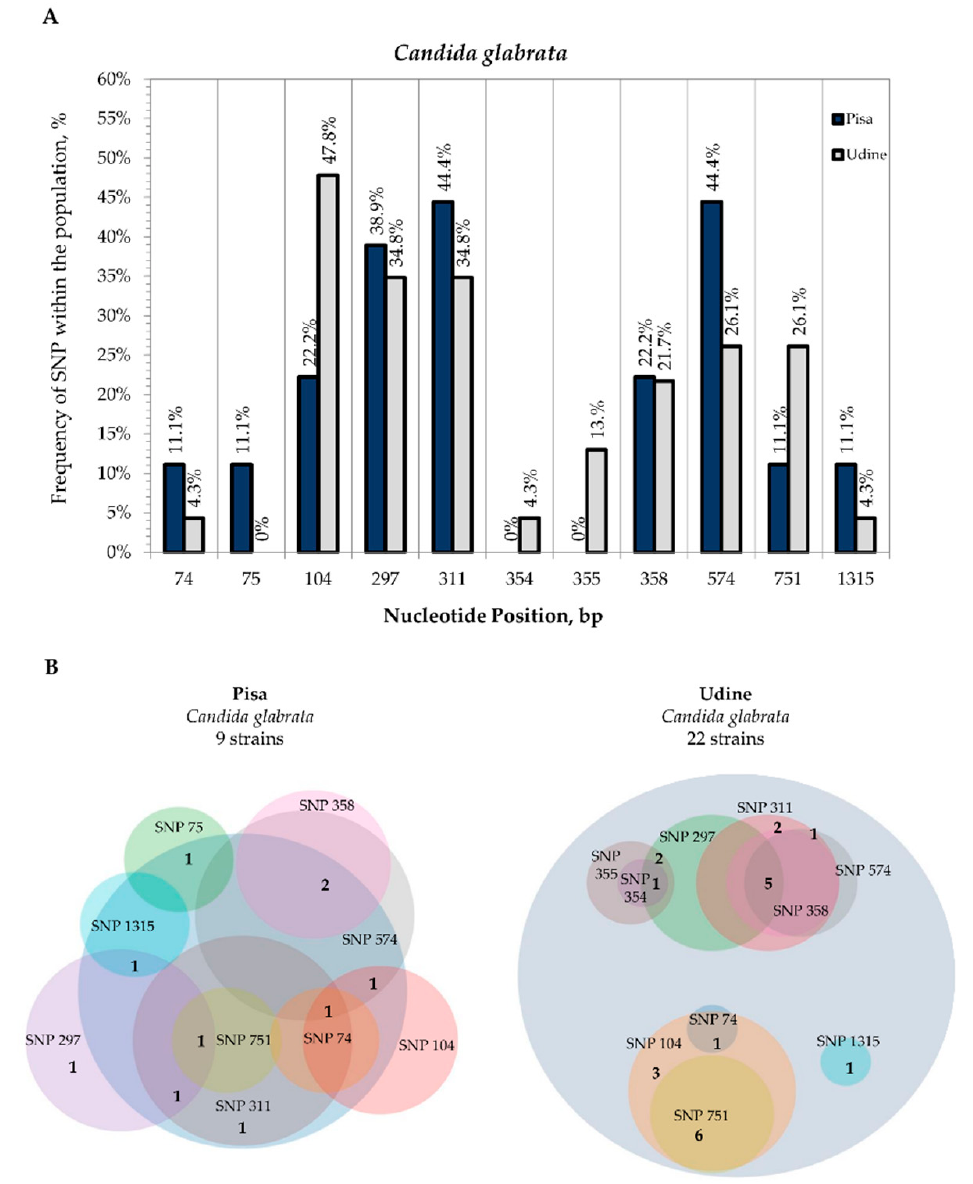
Figure 5. Internal variability of C. glabrata species (SNPs). ( A ): Frequency of SNP within the population ( y -axis) vs. nucleotide position ( x -axis). For both sampling sites, SNP frequencies were calculated on the basis of the coverage in the multiple sequence alignment of all the second-level consensus sequences with the type strain. Frequencies of SNPs from Pisa Hospital (blue columns) and Udine Hospital (grey columns). ( B ): Venn diagrams of strains isolated from Pisa Hospital and Udine Hospital that displayed the presence of SNPs.